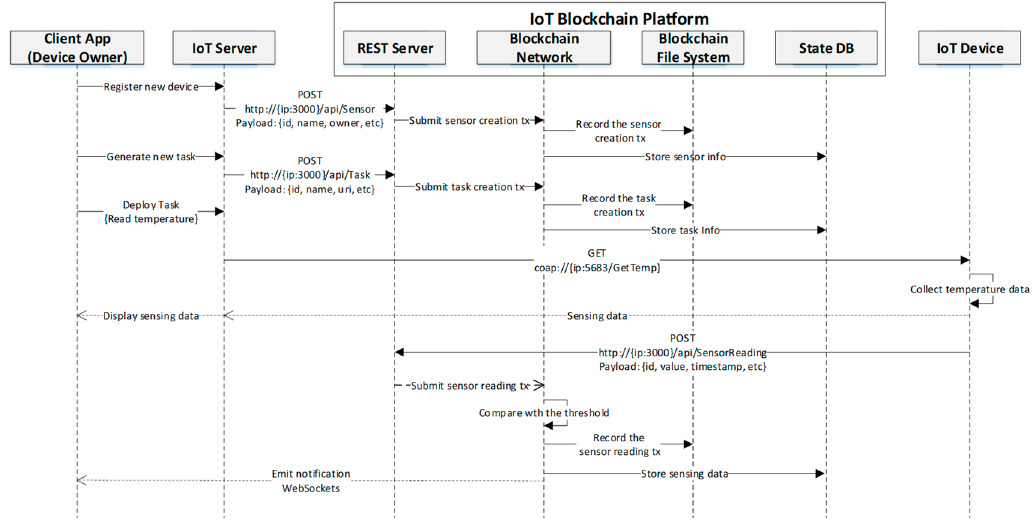
Figure 11 . Execution process for the implemented case study.